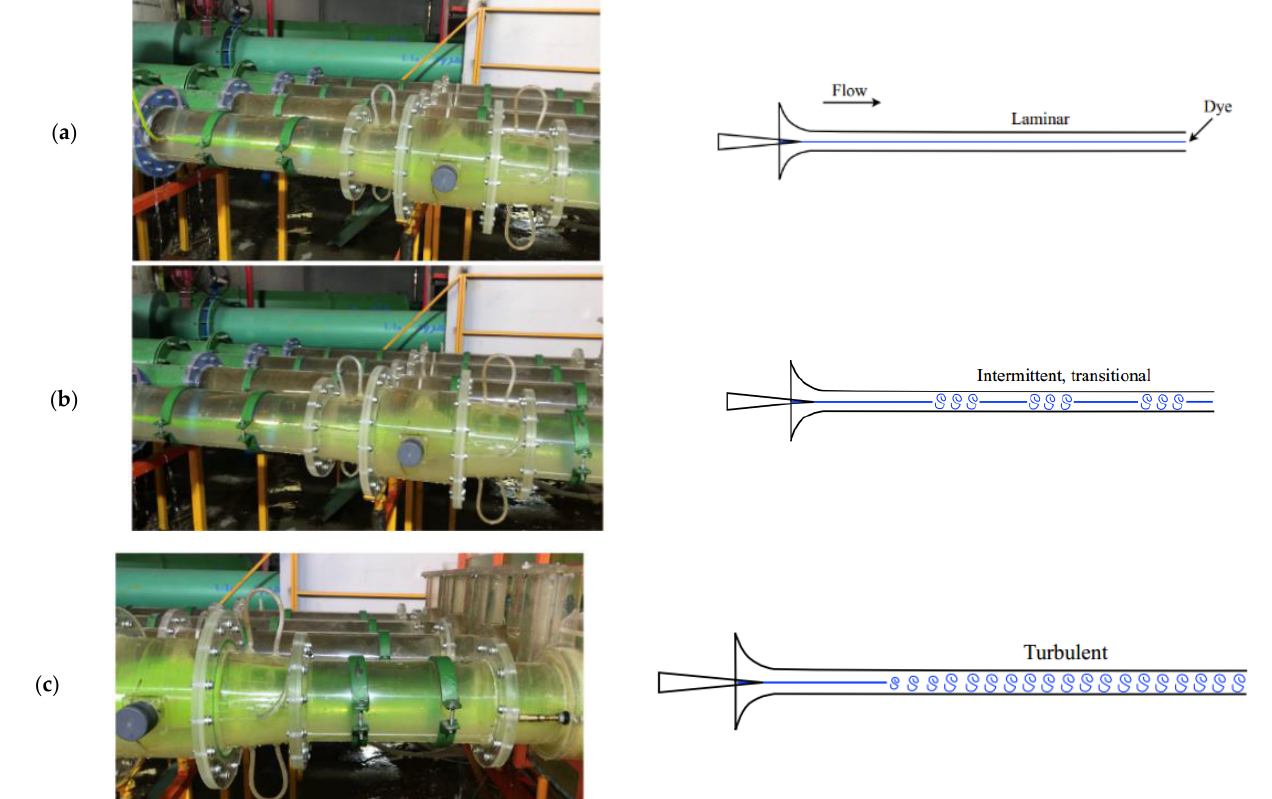
Figure 13. The regimes of pipe flow are illustrated by experimental modelling and sketches modeled after those in Reynolds (1883): ( a ) at low flow velocities, the fluid motion is laminar and dye injected at the pipe inlet produces a straight streamline; ( b ) the transitional regime occurs at intermediate flow velocities where the flow exhibits irregular, intermittent turbulence; and ( c ) at high flow velocities, swirling motions of injected dye reveal that the fluid becomes turbulent within a short distance of the pipe inlet.